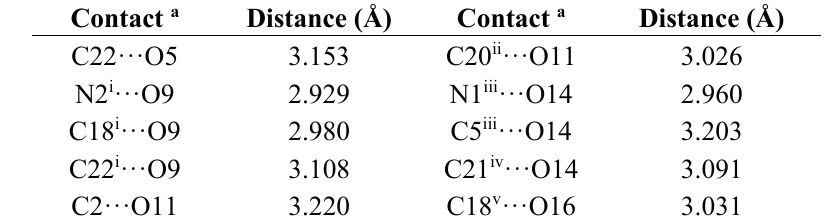
Table 3. Short contacts between W 10 and the heterocyclic moiety of C 12 py in 2 . Contact